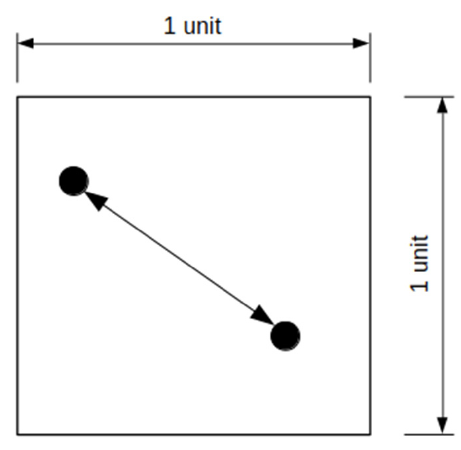
Figure 6. Average distance between any two nodes.